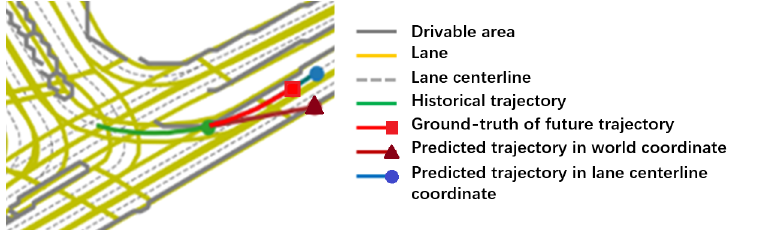
Figure 4. Visualization of the trajectories directly predicted in the world coordinate and by the proposed framework (which can be better viewed in color).